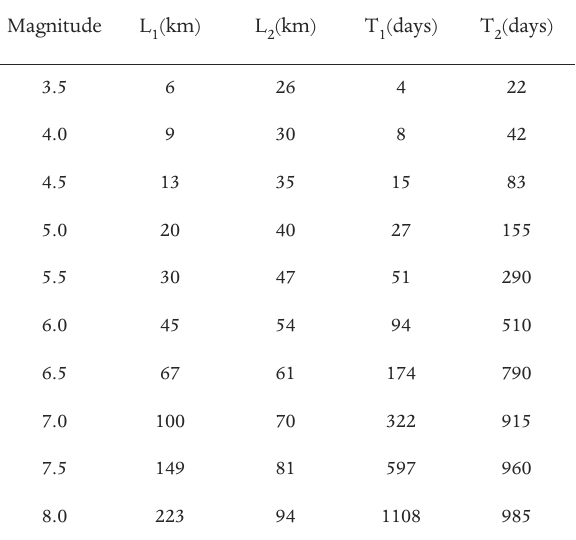
Table 8. Aftershock identification windows, T distance windows according to Uhrhammer [1986], T and distance windows according to Gardner and Knopoff [1974].